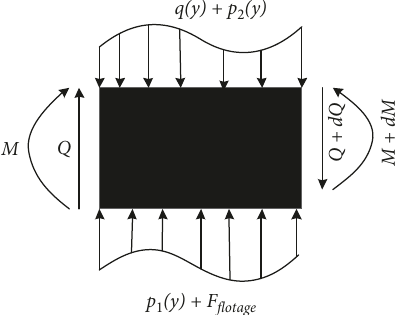
Figure 6: Diagram of forces on